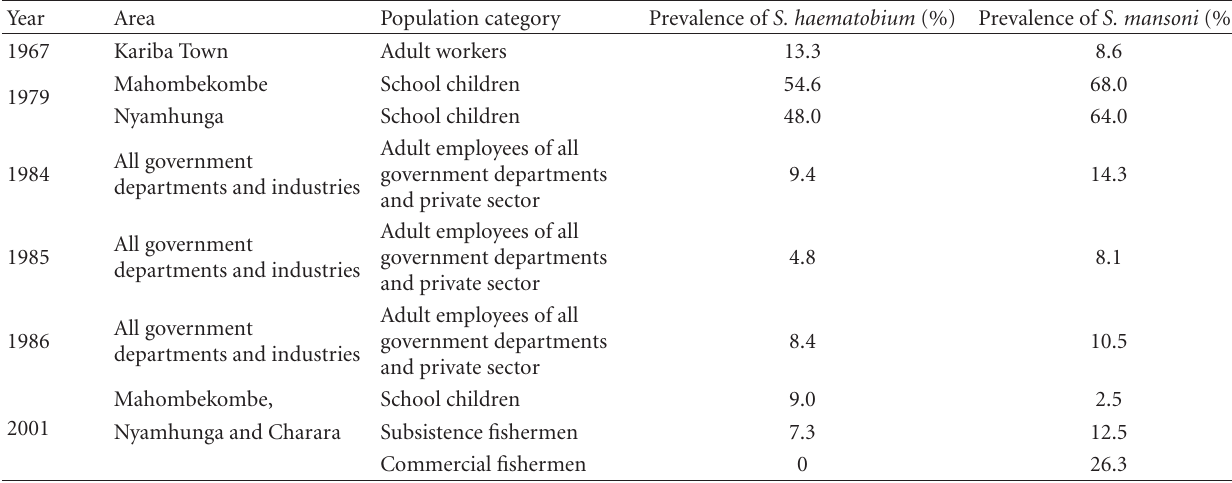
Table 1: Results of schistosomiasis surveys conducted around Kariba town [15].